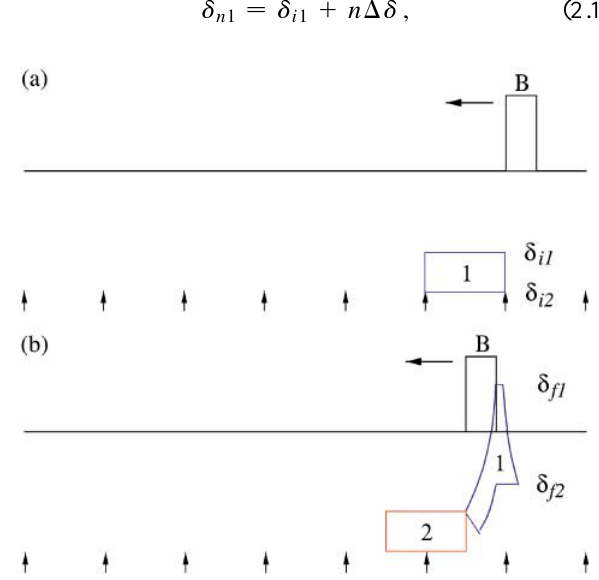
FIG. 2. (Color) (a) A booster batch with its head at the left (marked 1) is injected at negative momentum offset with the right edge just touching a left-moving barrier (marked B). The vertical arrows are spaced one booster-batch length T b . (b) After a booster cycle, the barrier moves by half a booster-batch length while all particles in batch 1 drift past the left edge of the barrier. After exiting the barrier, the batch has maximum and minimum momenta, d f 1 and d f 2 , symmetric about the on- momentum particles. A second booster batch (marked 2) is now